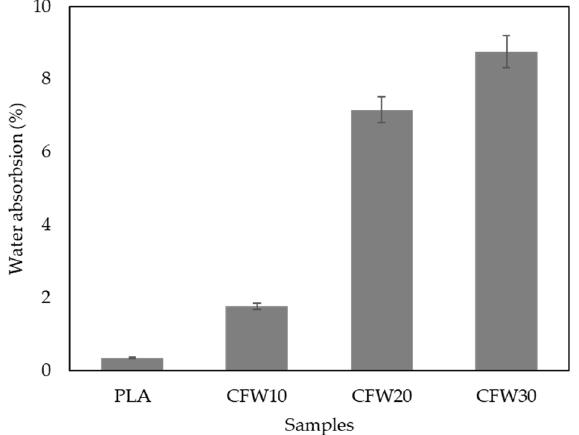
Figure 10. Water